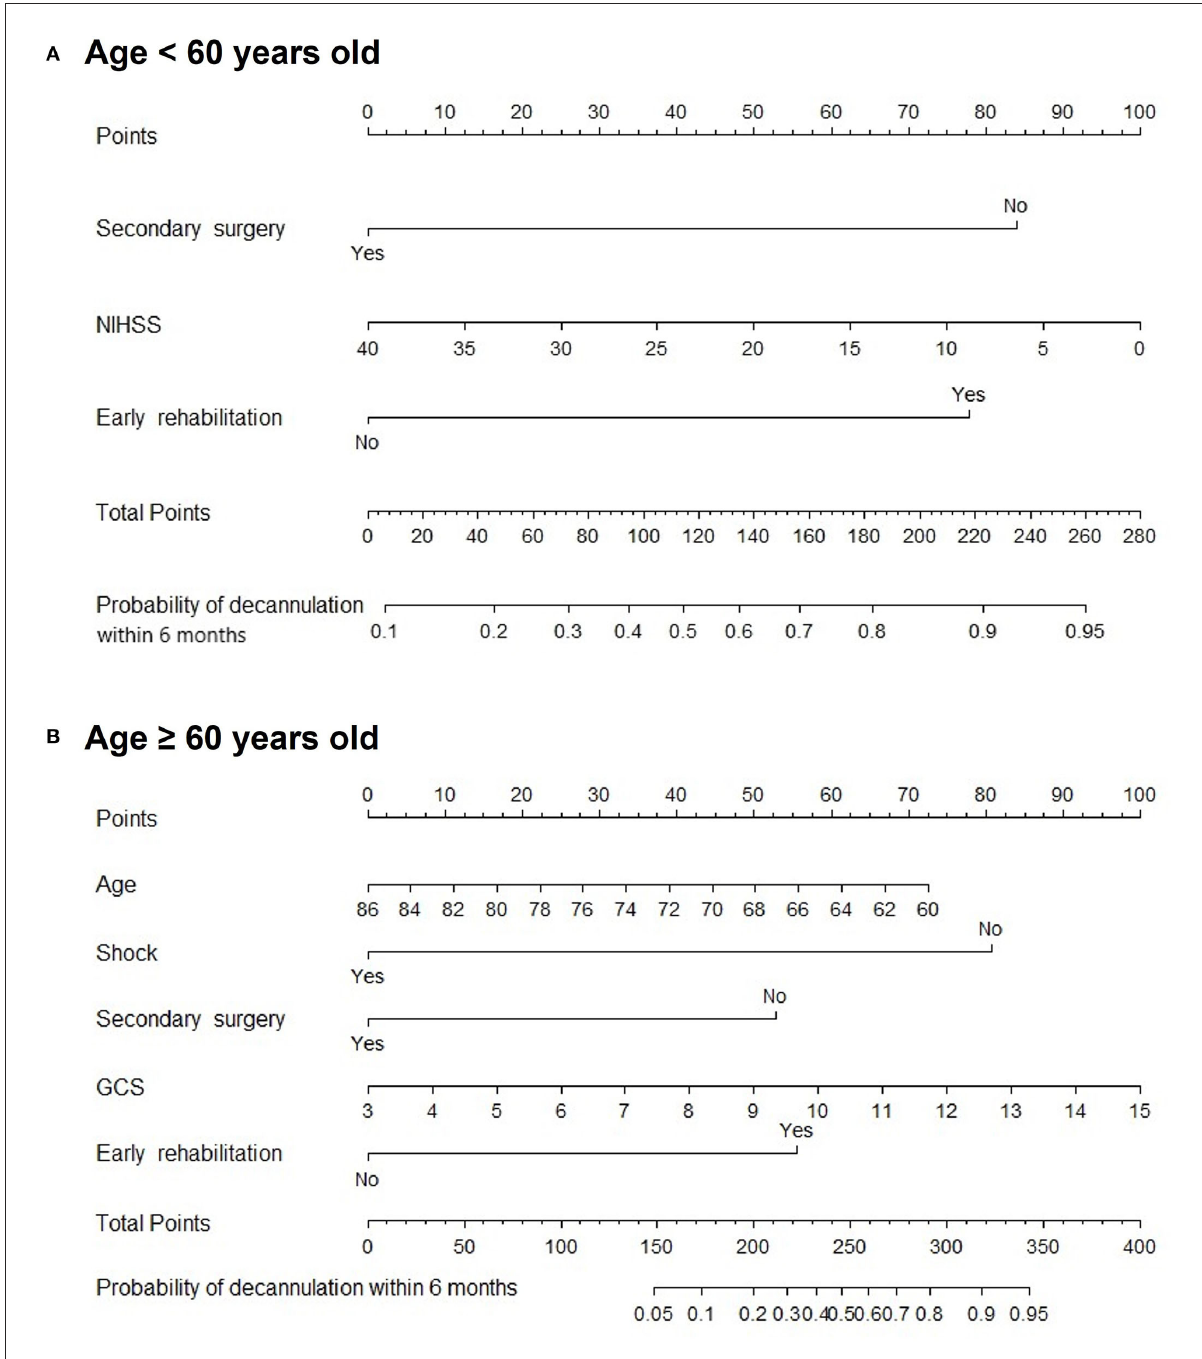
FIGURE5 Nomogram for predicting 6-month decannulation probability in subgroup stratified by age. (A) Patients younger than 60 years old. (B) Patients aged 60 years or older.